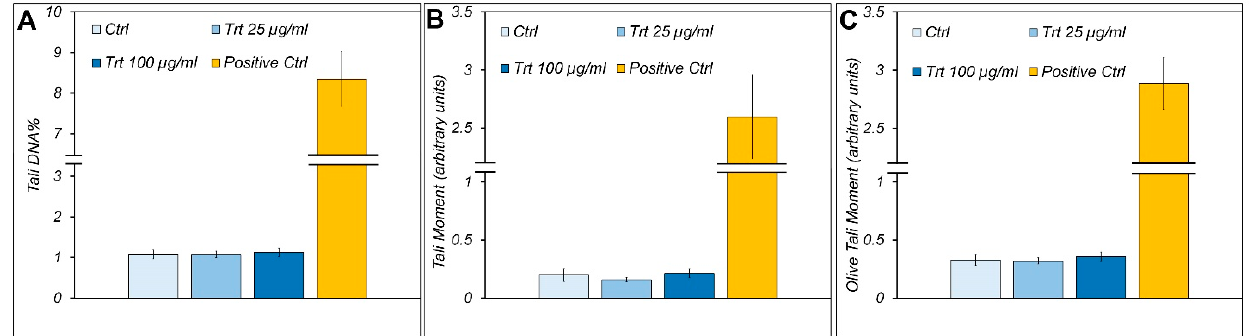
Figure 2. Alkaline comet assay . Evaluation of DNA damage by the alkaline comet assay in RAW cells, treated (Trt) or untreated (Ctrl) for 48 h with 25 or 100 μ g/mL of passenger tire wear particles. cells, treated (Trt) or untreated (Ctrl) for 48 h with 25 or 100 µ g/mL of passenger tire wear particles. Positive control = 100 μ M H 2 O 2 at 4 °C for 30 min. Histograms show means ± S.E.M (n = 200) of tail Positive control = 100 µ M H 2 O 2 at 4 ◦ C for 30 min. Histograms show means ± S.E.M (n = 200) of tail DNA % ( A ), tail moment ( B ), and olive tail moment ( C ). DNA % ( A ), tail moment ( B ), and olive tail moment ( C